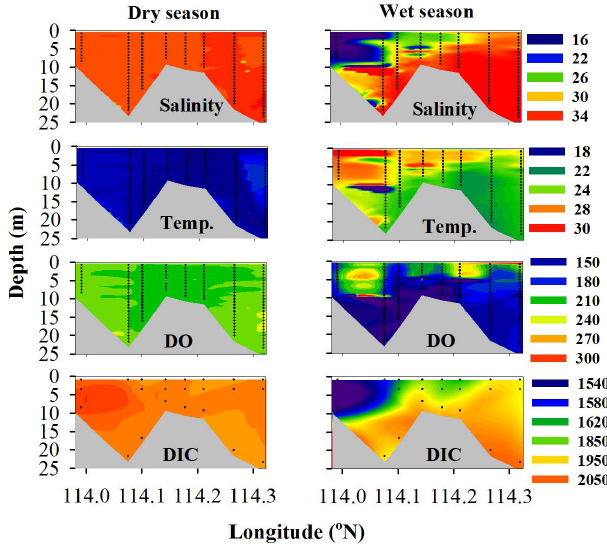
Fig. 3. Vertical contour of salinity, temperature ( ◦ C), dissolved oxy- gen (µM) and dissolved inorganic carbon (DIC, µM) from S1 near the Pearl River estuary to S8 in eastern coastal/shelf waters in (A) the winter dry season (March 2006) and (B) the summer wet season (July